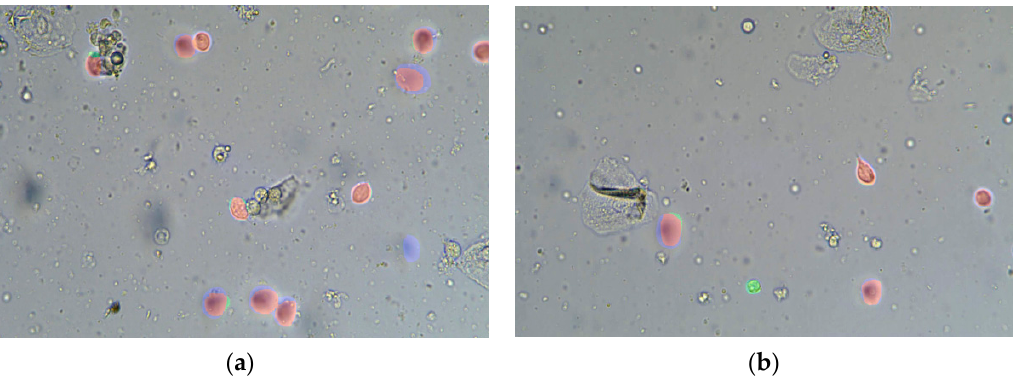
Figure 9. The limitation of the rough detection network. For convenience of display, we have used red to mark the TP regions, green to mark FN regions and blue to mark FP regions of TV on the original image. ( a ) The false alarms of TV; ( b ) the missed detection of TV.